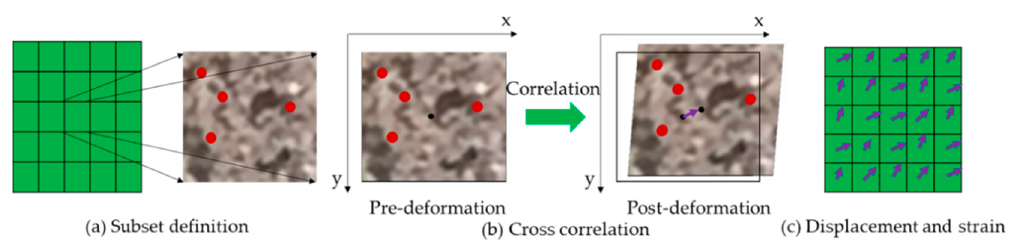
Figure 1. Working principle of digital image correlation.